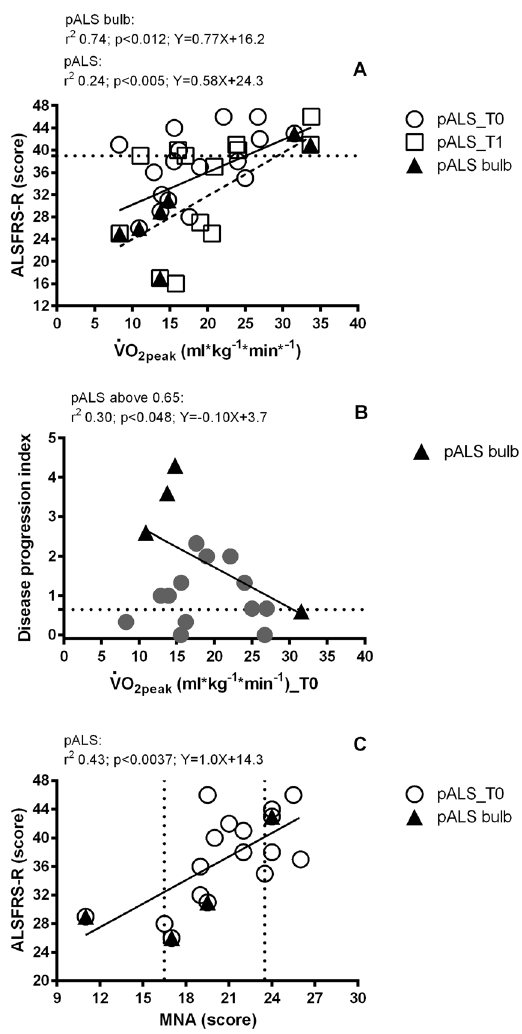
Figure 3. Panel (A) Correlation between  V O 2 values at exhaustion and clinical scores of ALS disease (ALSFRS-R questionnaire), recorded at baseline (T0) and after 4 months (T1). Patients with ALSFRS-R score lower than 39 (dotted line) had shorter survival time. The broken line is related only to pALS bulb. Panel (B) Correlation between  V O 2 peak and the change in ALSFRS_R score after 4 months (T1–T0). Patients with ALSFRS-R score higher than 0.65 (dotted line) had shorter survival time. Panel (C) Correlation between Mini Nutritional Assessment (MNA) questionnaire scores and ALSFRS-R at T0. Patients with 16.5 < MNA < 25 had a risk of malnutrition, while patients with MNA < 16.5 were malnourished. White circles: pALS at T0; white squares: pALS at T1; black triangles: pASL with bulbar onset (pALS